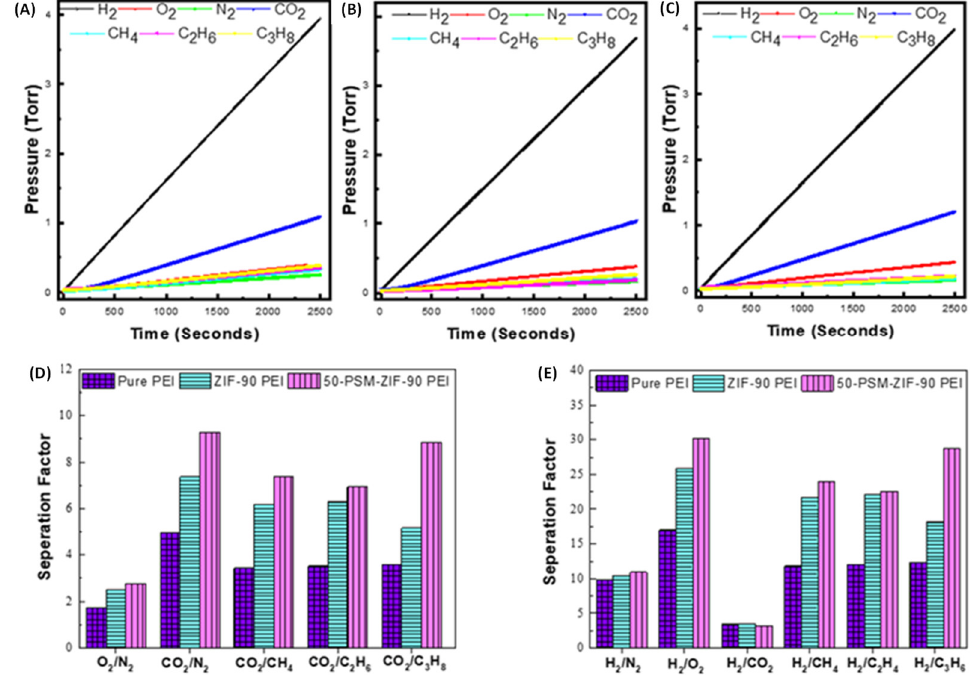
Figure 14. Single Gas permeation curves of ( A ) Pure PEI membrane, ( B ) ZIF-90 PEI, and ( C ) 50-PSM- ZIF-90 PEI membranes; Selectivity of Pure PEI membrane, ZIF-90 PEI and 50-PSM-ZIF-90 PEI mem- branes ( D ) O 2 and CO 2 separation ( E ) H 2 separation.